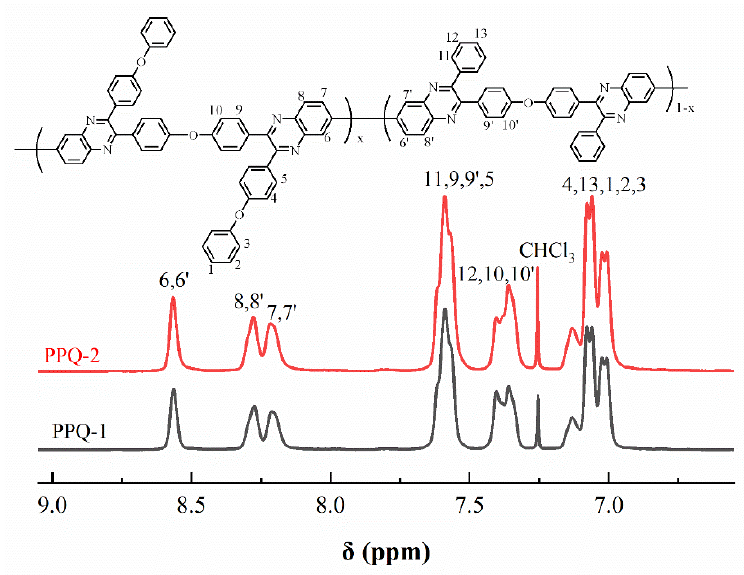
Figure 5. 1 H-NMR spectra of PPQs.